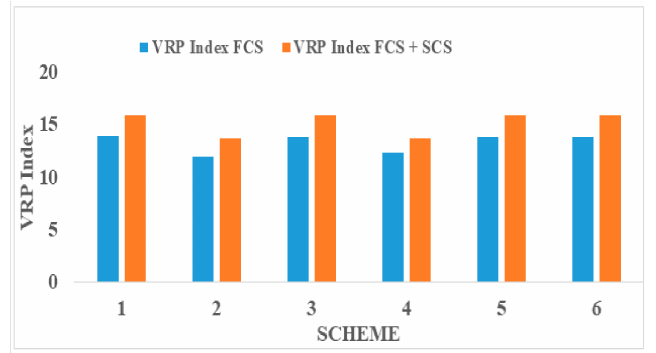
Figure 5. VRP index of modified IEEE 33-bus system considering both FCSs and SCSs. Table 8. Optimal location of CSs based on VRP index for 33-bus system. Bus Number of FCS Number of